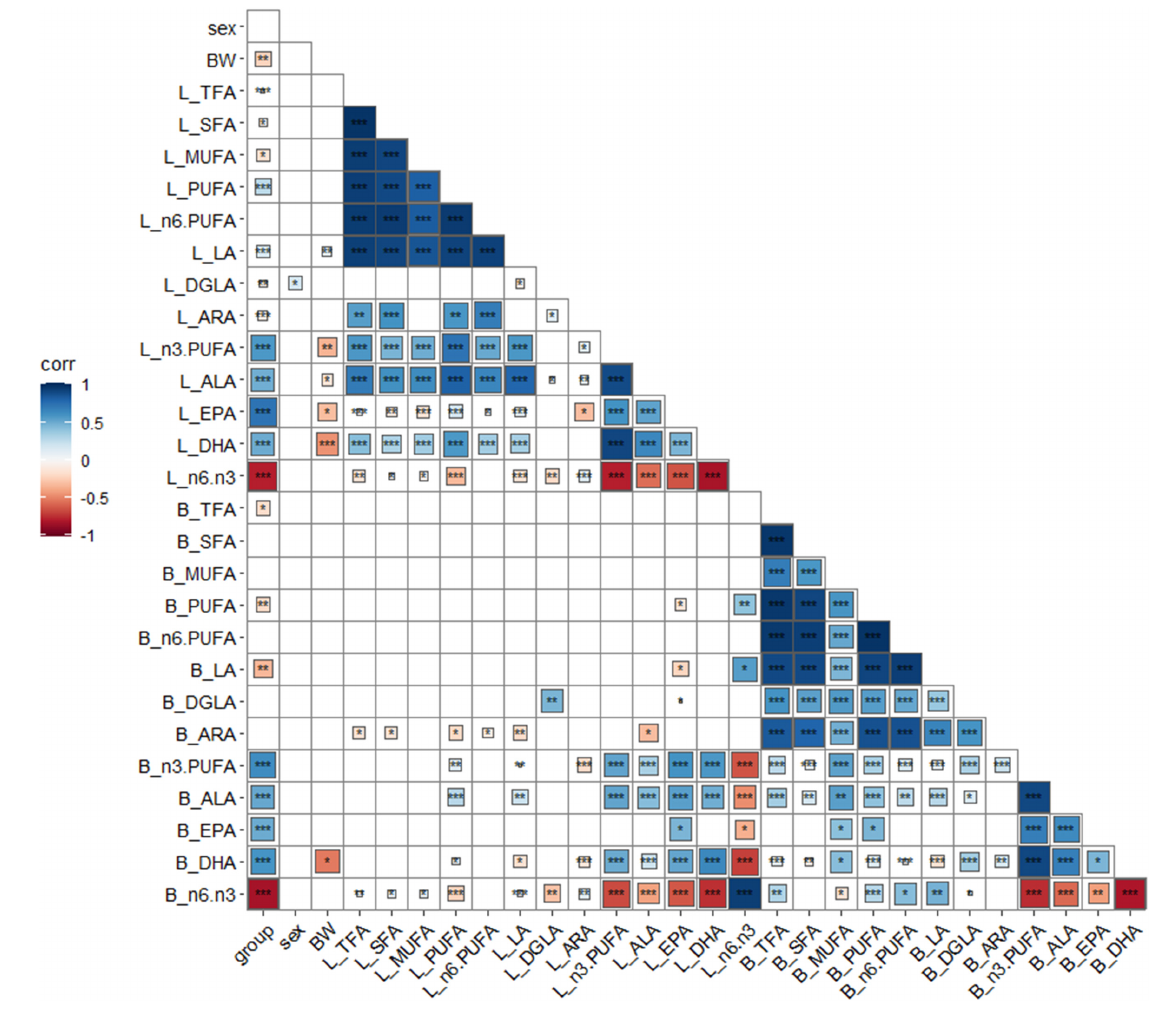
FIGURE1 Correlation analysis of key indexes. * P < 0.05, ** P < 0.01, *** P < 0.001, blue positive correlation, red negative correlation, darker color, higher correlation, lighter color, lower correlation. Group: different diet group; sex, sex; BW, body weight; B, breast muscle; L,